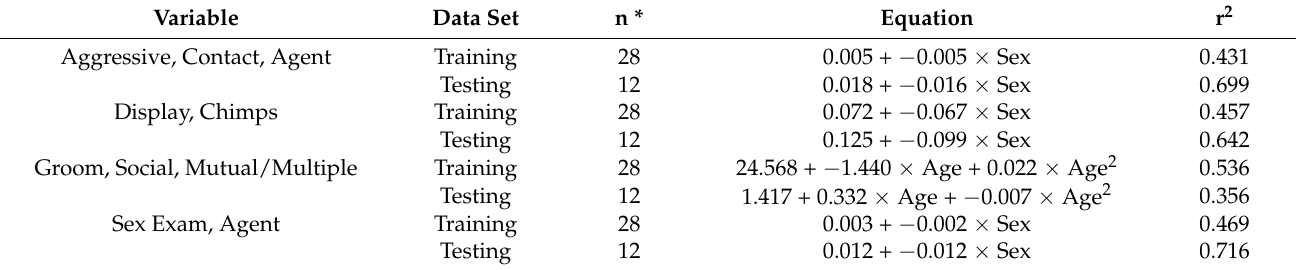
Table 1. Fit of predictions on the training and testing datasets from the linear regression models. Training sets included 70% of the data, and testing sets included 30% of the data.